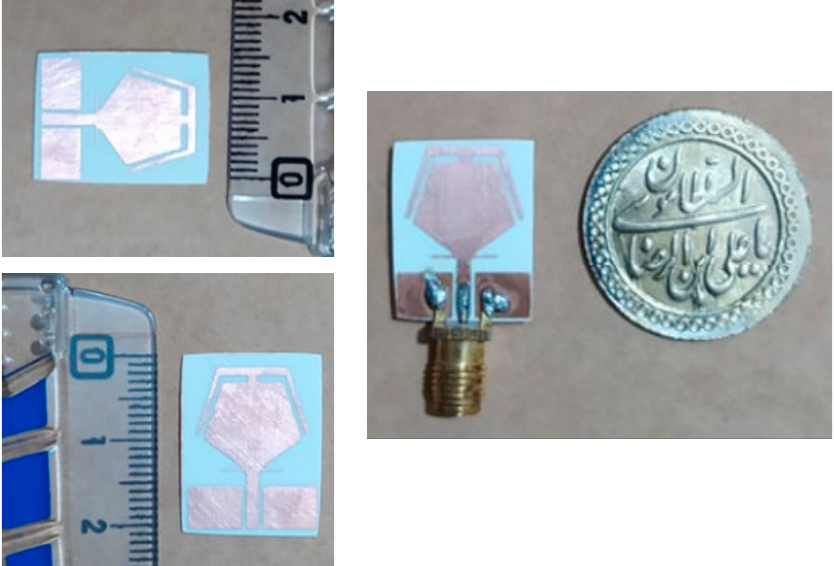
Figure 9. Fabricated prototype of the proposed antenna.